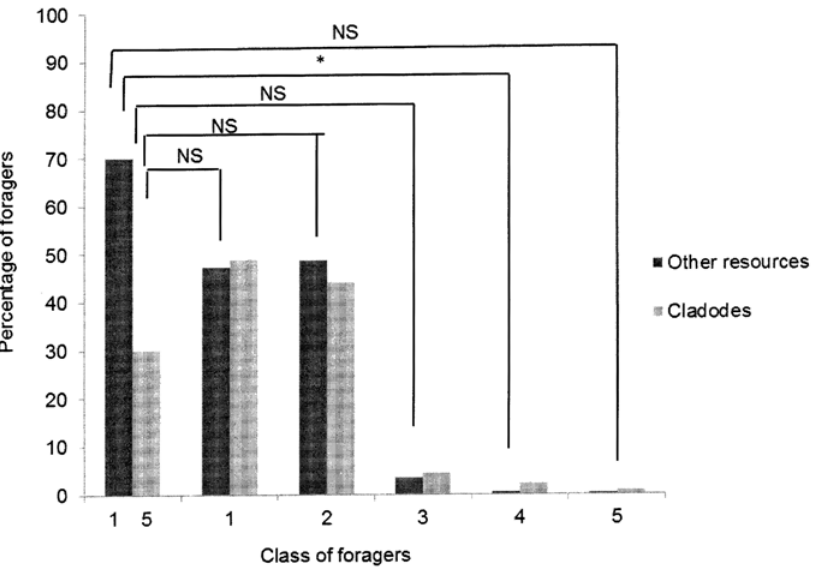
Fig. 4. Percentage of foragers of Atta robusta that transported cladodes compared with those that transported other resources. NS = no significant difference by test χ2, * significant difference, p <0.0171. Class 1 (χ2 = 0.07 and p = 0.79), class 2 (χ2 = 0.60 and p = 0.43), class 3 (χ2 = 0.44 and p = 0.50), class 4 (χ2 = 5.69 and p <0.0171) and class 5 (χ2 = 0.76 and p =